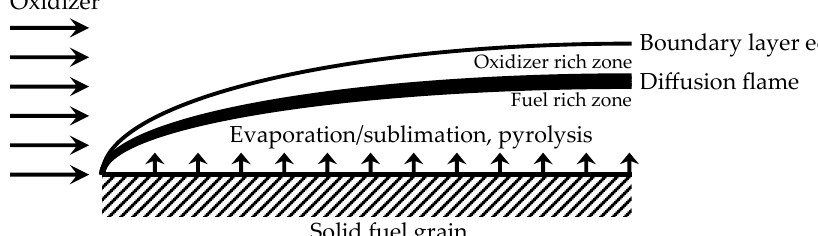
Figure 2. Schematic overview of the hybrid boundary layer combustion, based on the fundamental work of